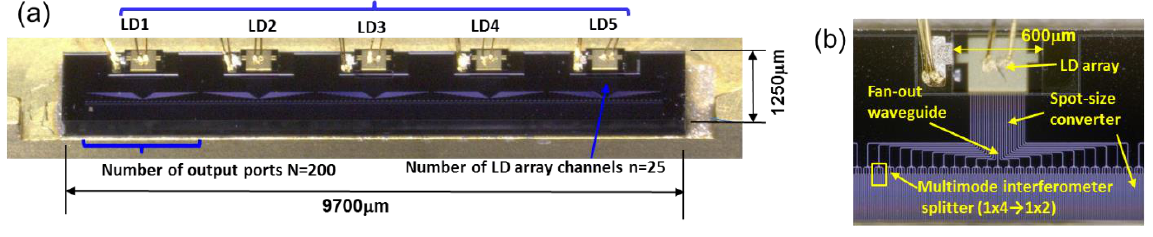
Figure 1. Microscope image of 1000-channel hybrid integrated light source with waveguide splitters and multiple laser diode (LD) array chips. ( a ) Overview; ( b ) Enlargement around mounted LD